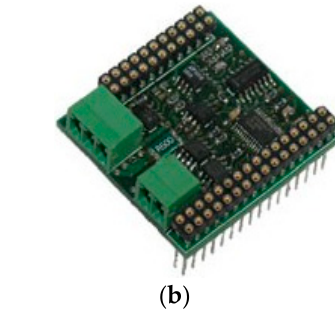
Figure 17. Fast high temperature isolated DC/AC current measurement. ( a ) Photograph of the bidirectional saturated current transformer, and ( b ) PCB circuit.